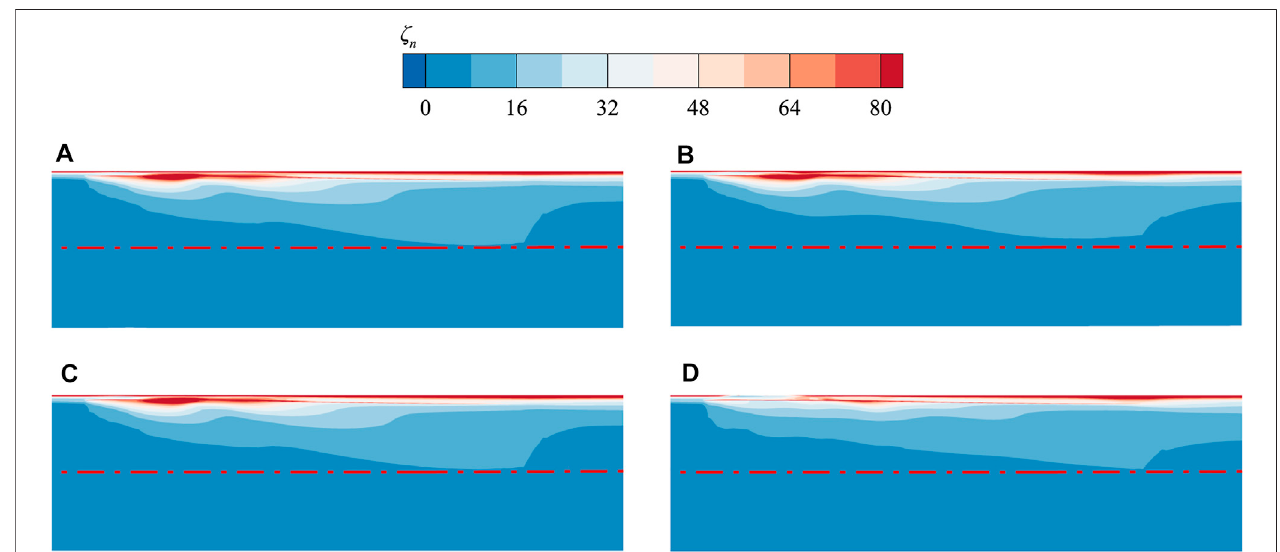
FIGURE 14 | Pitch-averaged absolute vorticity coef fi cient contours near the tip region. (A) Smooth casing (B) Max PEI point (C) TOPSIS point (D) Max SMI point.